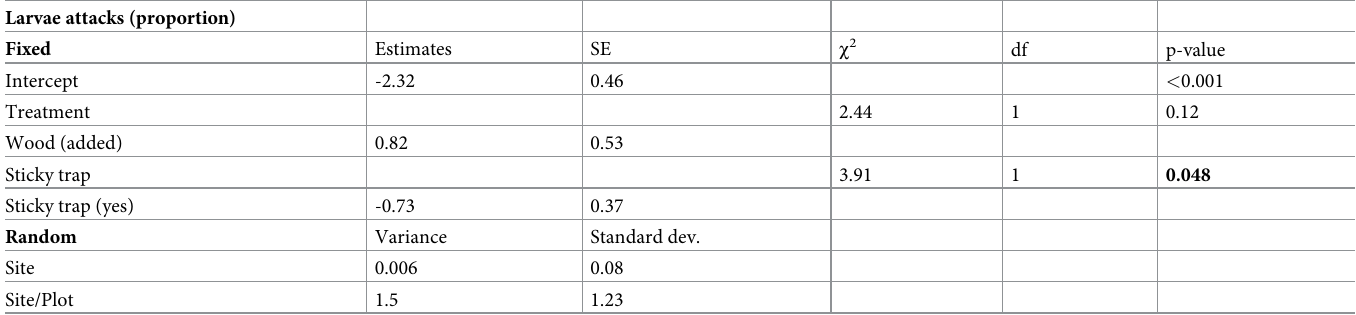
Table 2. Anova (type II test) and summary table for generalised linear mixed models testing the difference in proportion of attacks against the dead wood treatment (added or removed). Dead wood treatment and sticky traps were used as a fixed factors, site and plot nested in site as a random factors. Significant effects are marked in bold.